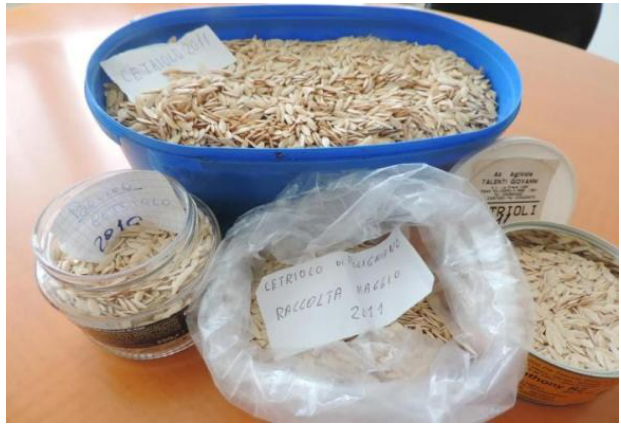
Figure 3. Example of accessions seeds recovered from farmers or simple enthusiasts during the WP2 activity (Photo credit: Beniamino